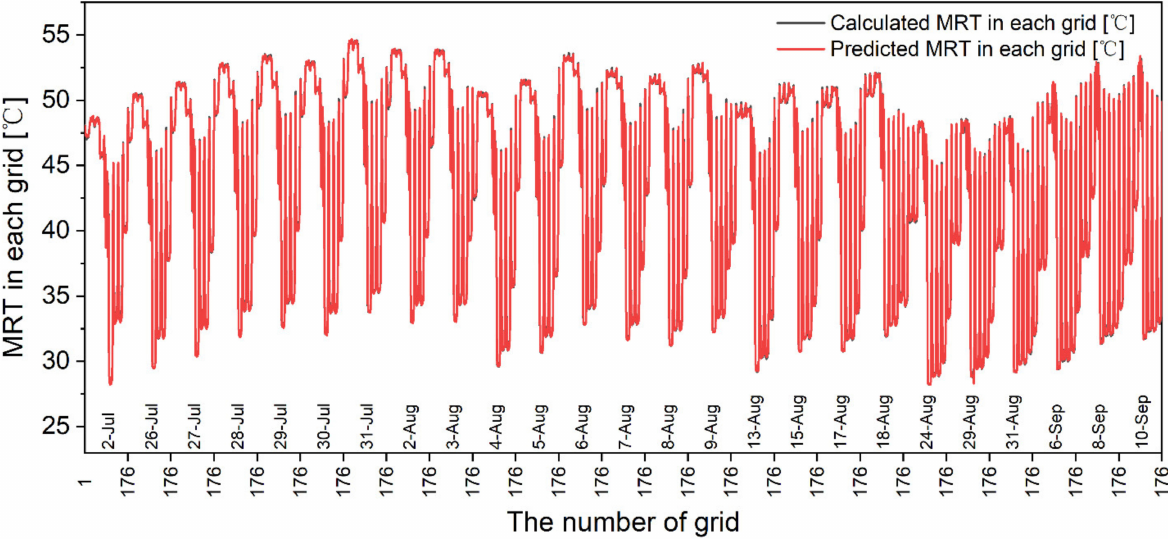
Figure 6. The validation results on the MRT distribution in each mesh on hot summer days in 2019.